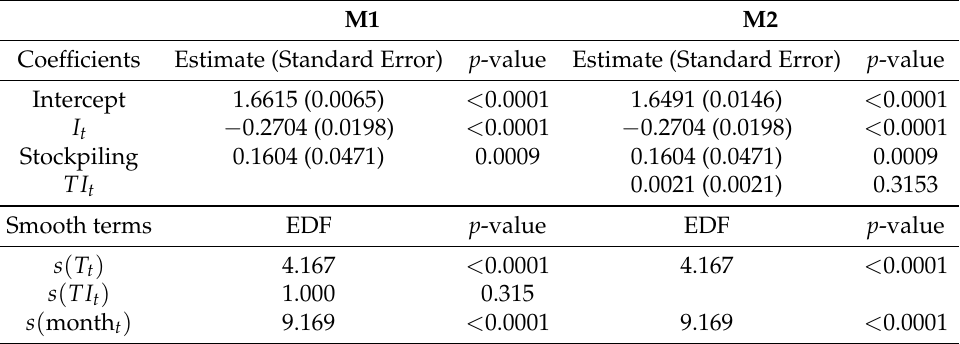
Table 5. Results of the generalized additive model for real data. M1